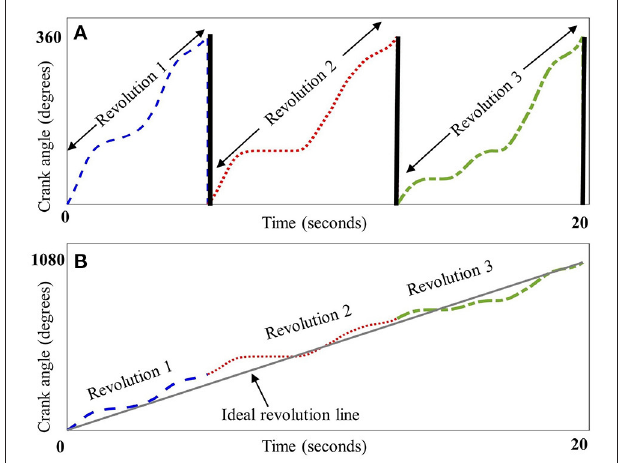
FIGURE 1 | Schematic representation of crank angle smoothness. Panel (A) depicts crank angle (plotted against time in seconds) for three representative revolutions from a child with CP, each dashed section depicting one revolution from 0 ◦ to 360 ◦ , thick black lines indicate the discontinuity between 360 ◦ and 0 ◦ at the end of each revolution. Panel (B) depicts the concatenation of these revolutions, resulting in a linear form that was cross-correlated with a line depicting an ideal, smooth revolution (straight gray